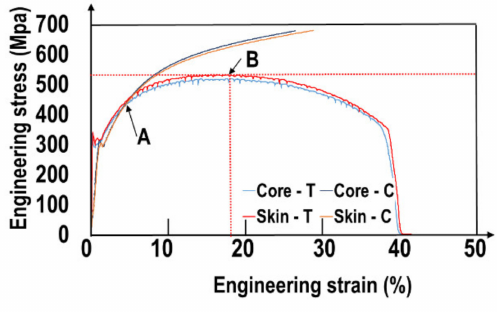
Figure 9. Tensile and compressive curve for skin and core